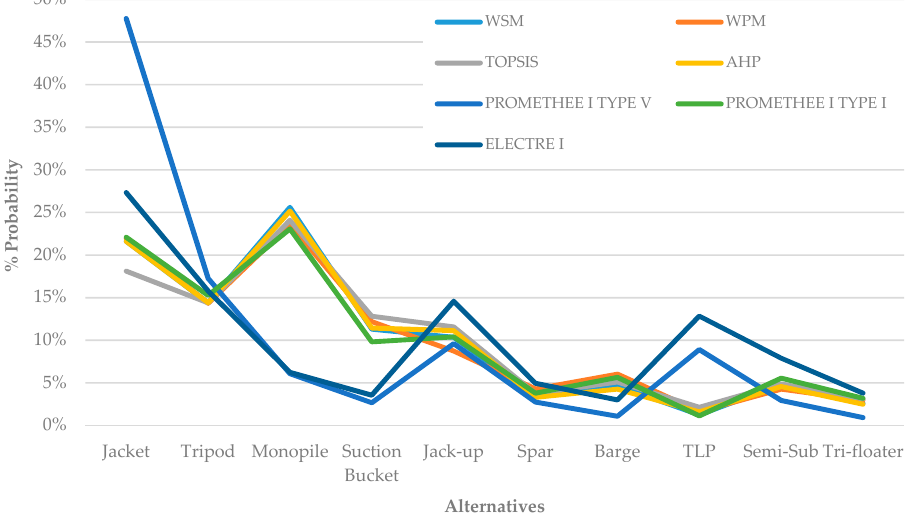
Figure 6 . Comparative stochastic MCDM results: probability of an alternative to score first.